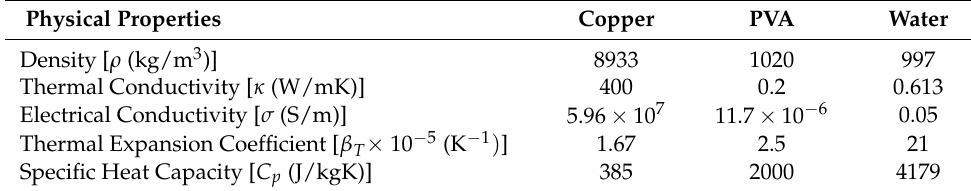
Table 3. Thermophysical properties of nanoparticles and basefluids ([12,53]).